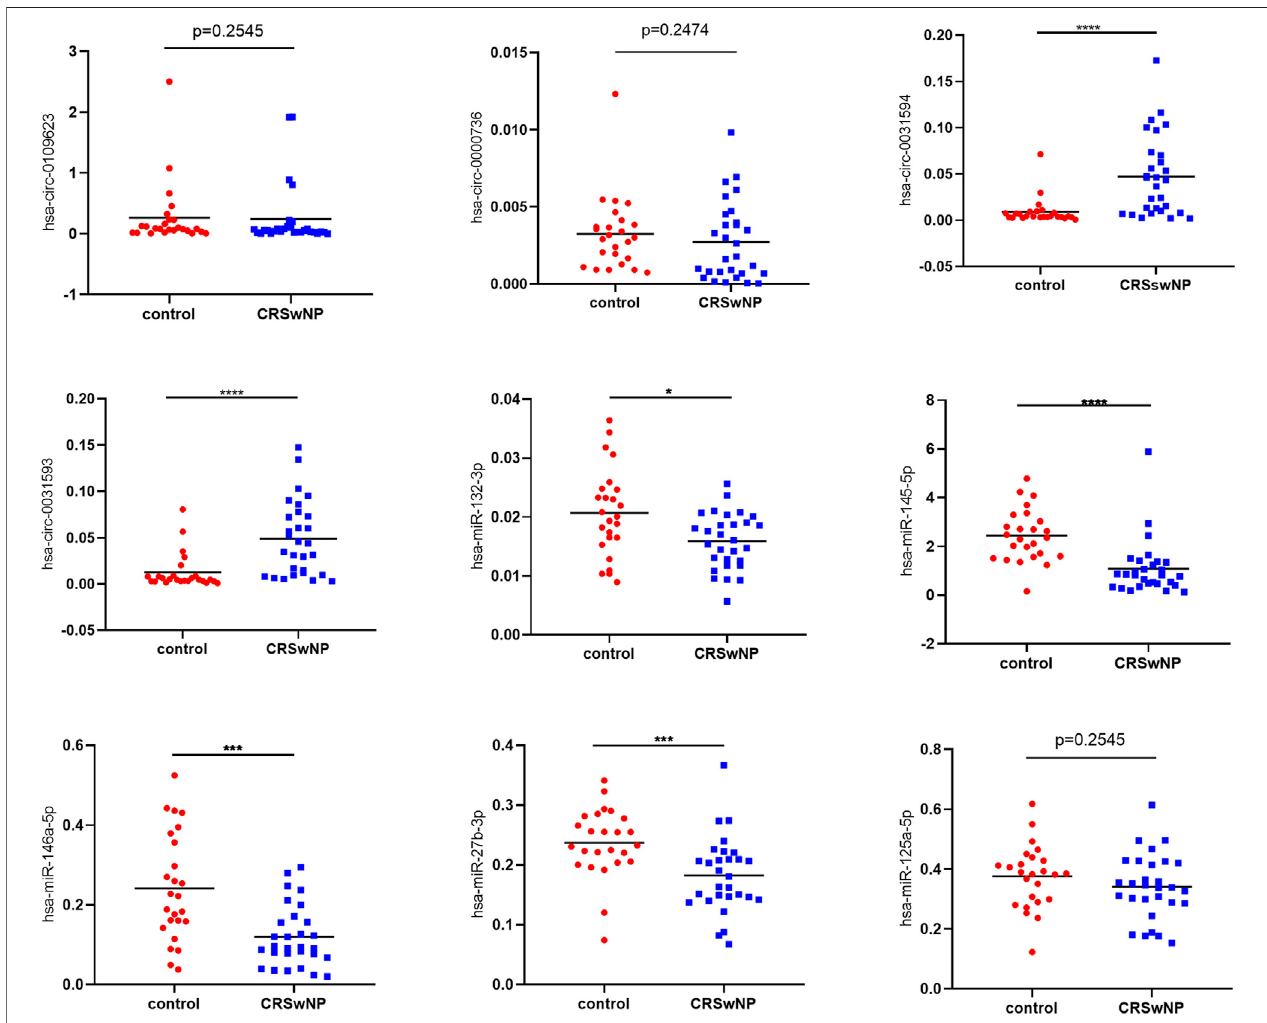
FIGURE 8 | Con fi rmation of the expression of circRNAs and miRNAs using quantitative real-time polymerase chain reaction (qRT-PCR). Sample numbers were expanded to perform qRT-PCR (CRSwNP ( n (cid:2) 29); control subjects ( n (cid:2) 25). GAPDH was used as the reference gene for circRNAs, and hsa-miR-16 was used as the referencegene formiRNAs.The heights ofcolumns represent thefold changes ofCRSwNP comparedwith thecontrolgroup. The relative expression levels ofhsa-circ- 0031593,hsa-circ-0031594, hsa-circ-0109623, hsa-circ-0000736, hsa-miR-132-3p, hsa-miR-145-5p,hsa-miR-146a-5p, hsa-miR-125a-5p and hsa-miR-27b- 3p by qRT-PCR. * p < 0.05, ** p < 0.01, *** p < 0.001, **** p <